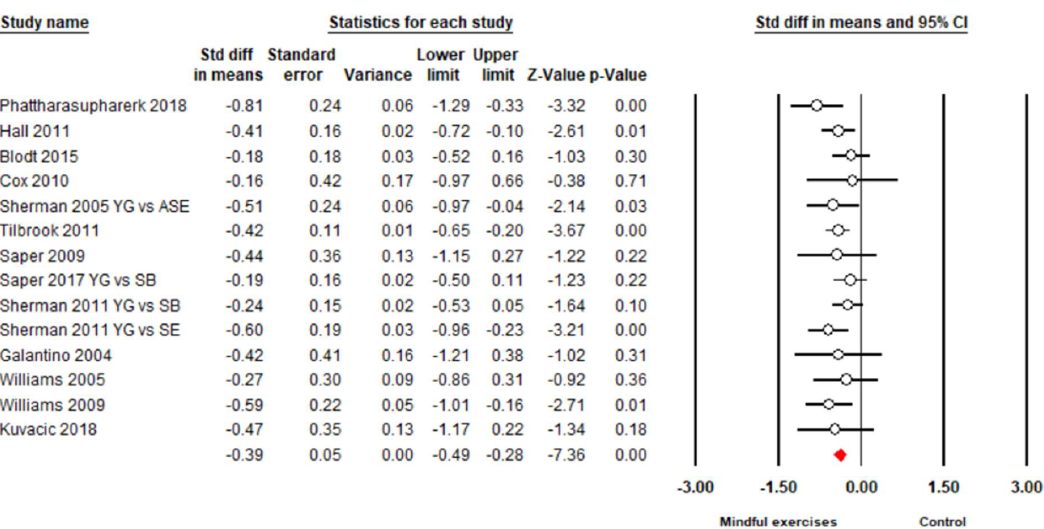
Figure 4. Funnel plot of publication bias for disability.